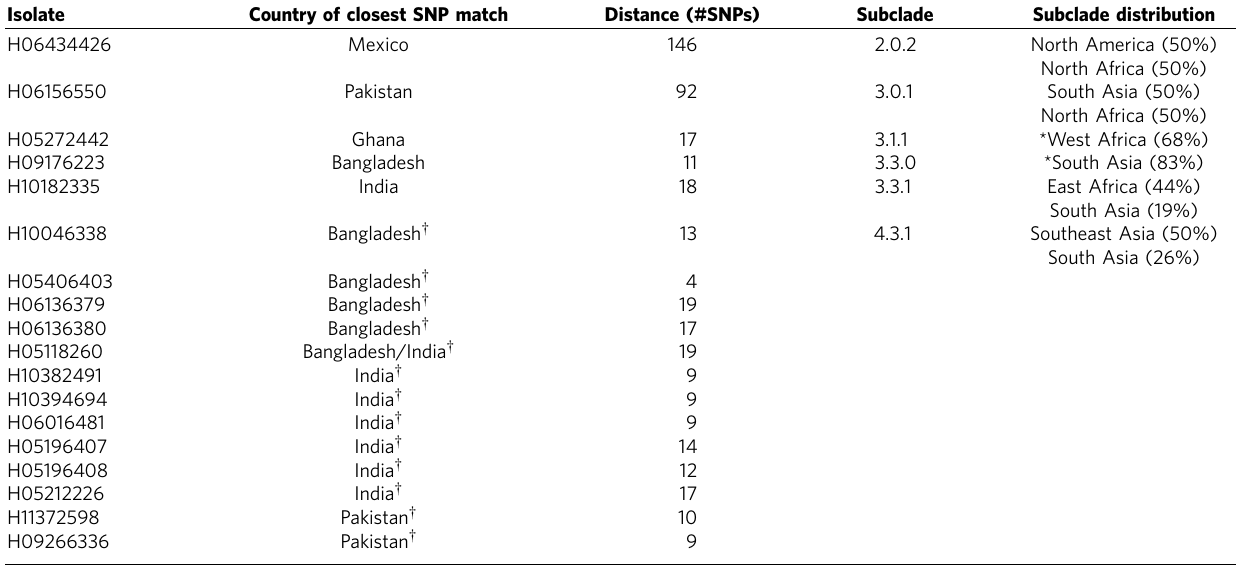
Table 4 | Summary of genotyping and SNP results for travel-associated S. Typhi isolates of unknown origin.